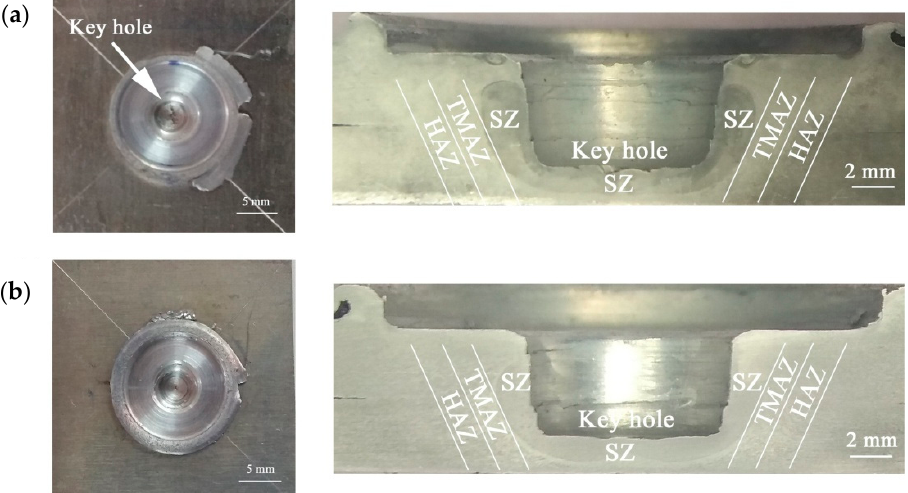
Figure 4. Crown appearances and cross-sectional views of the FSSW joints: ( a ) AA5083/nano-SiC, and ( b ) AA5083/micro-SiC.